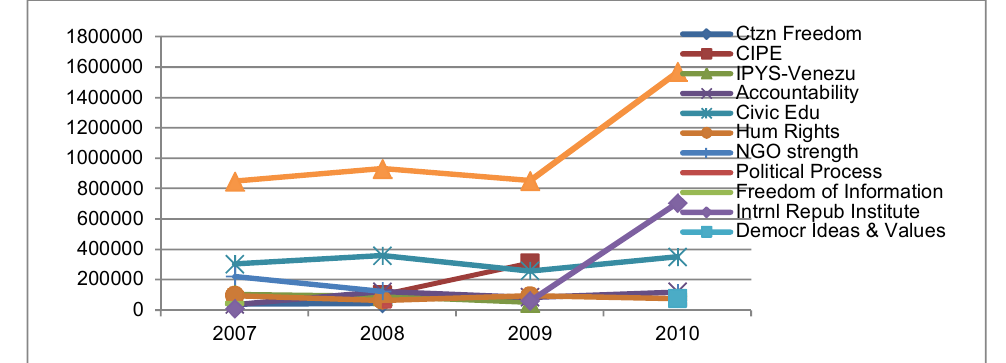
Figure 12: Different NED Grants for